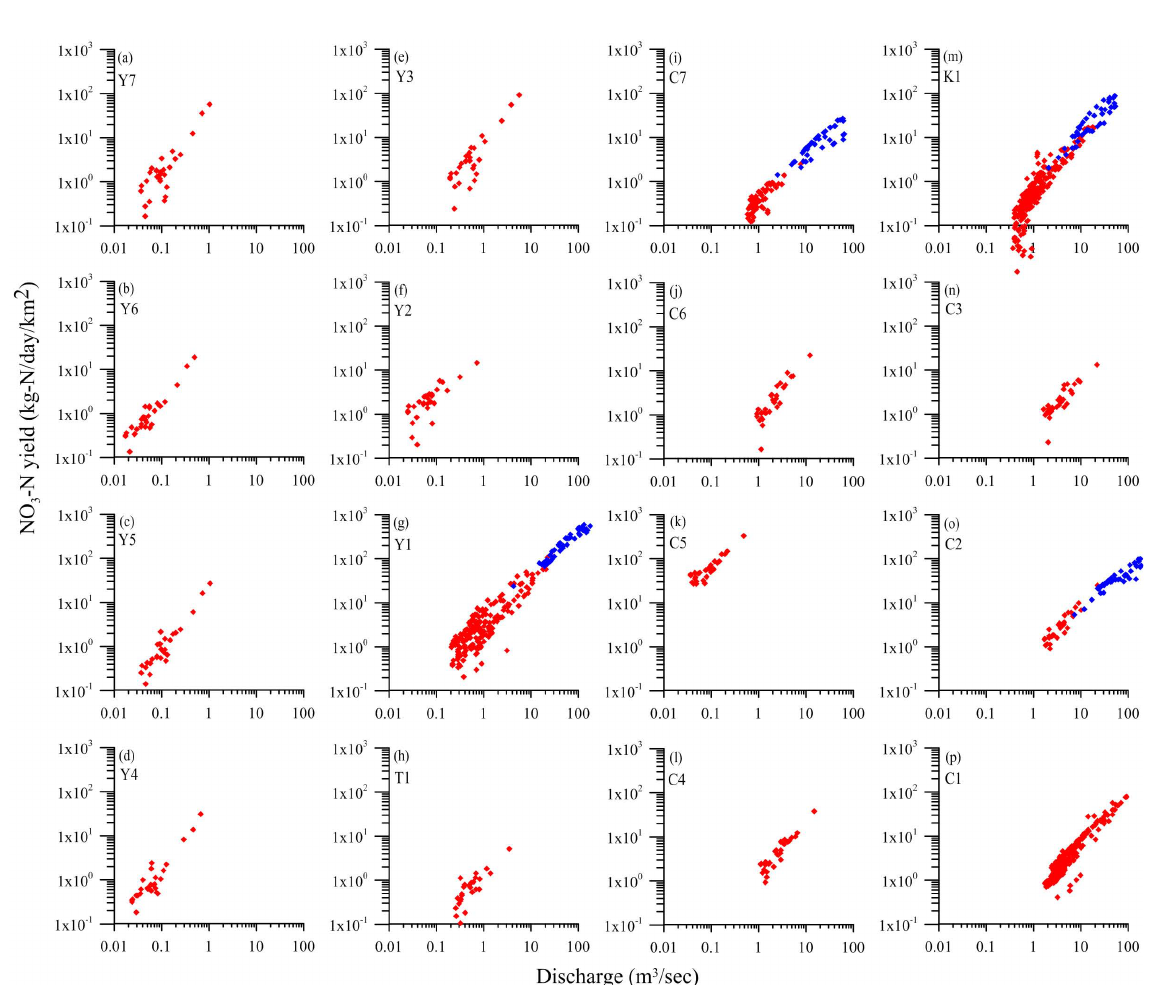
Fig. 5. The relationship between the specific NO 3 -N flux (y-axis) versus the daily discharge (x-axis) among the 16 sites. The blue circles stand for the typhoon